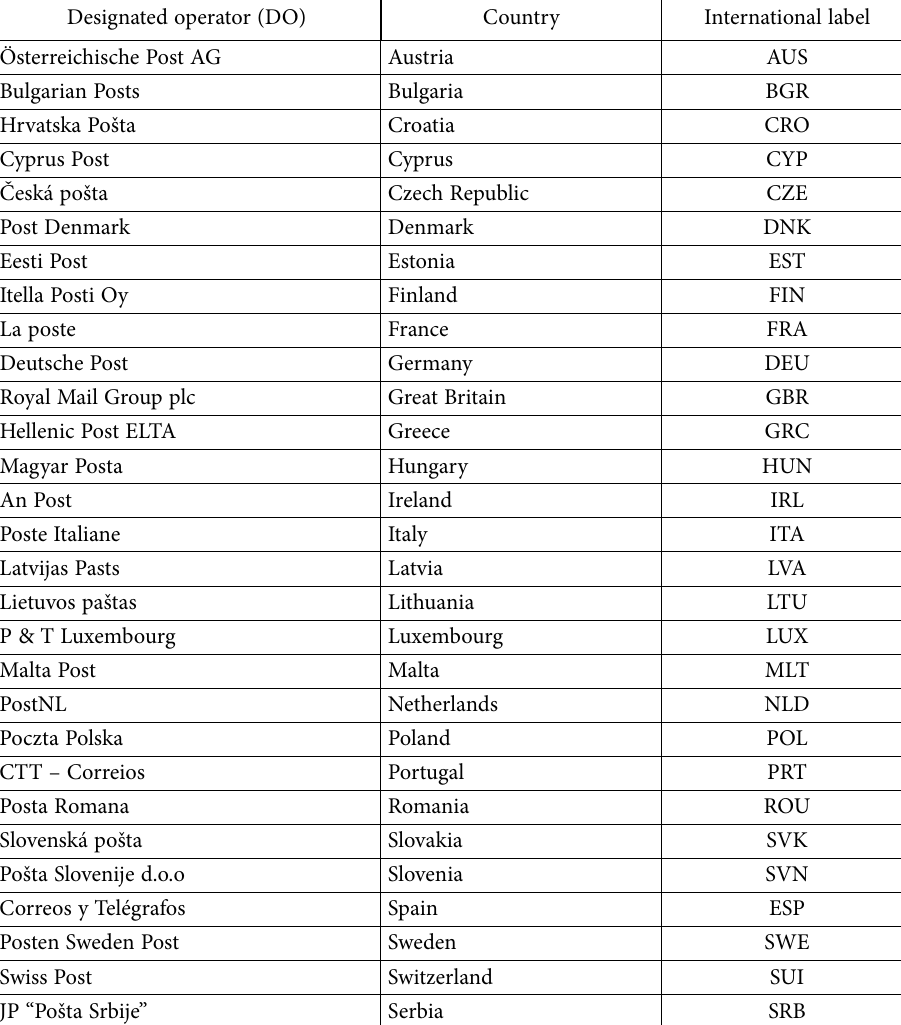
Table A1. Sample (source: International Trade Statistics